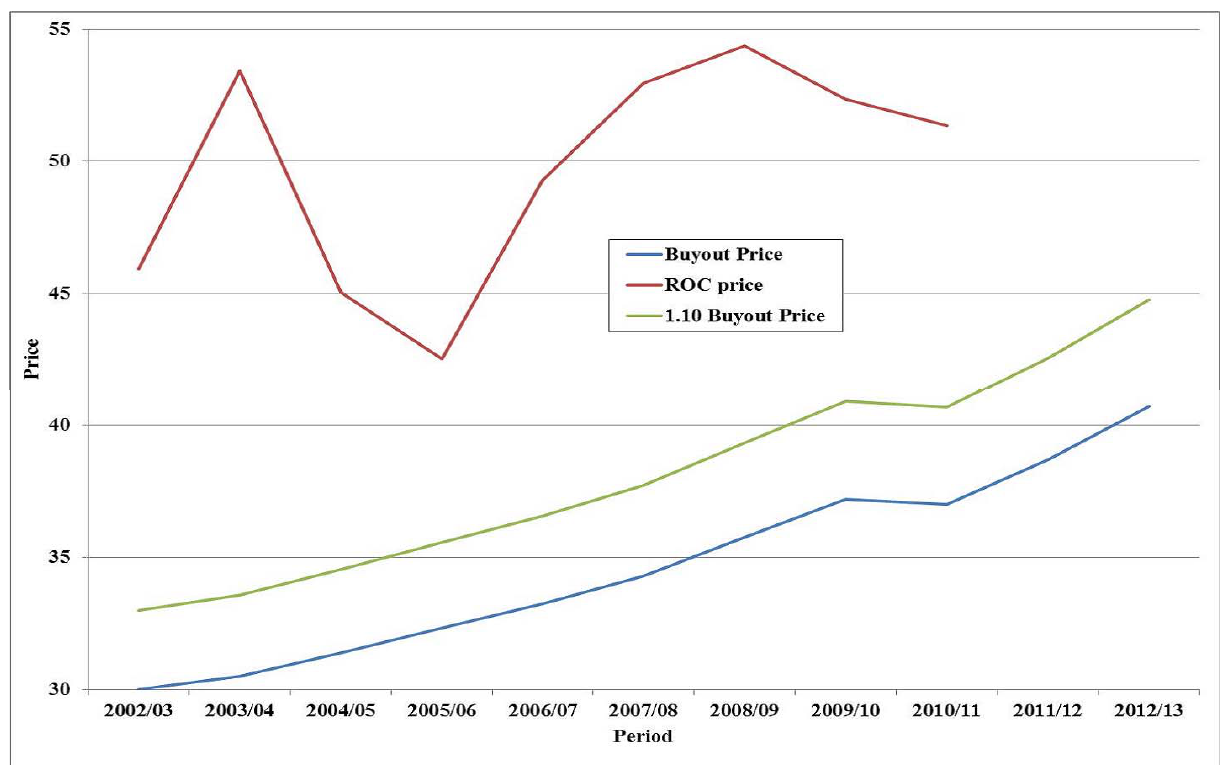
Figure 4. Time path of buy-out price and ROC price ( ₤ ).